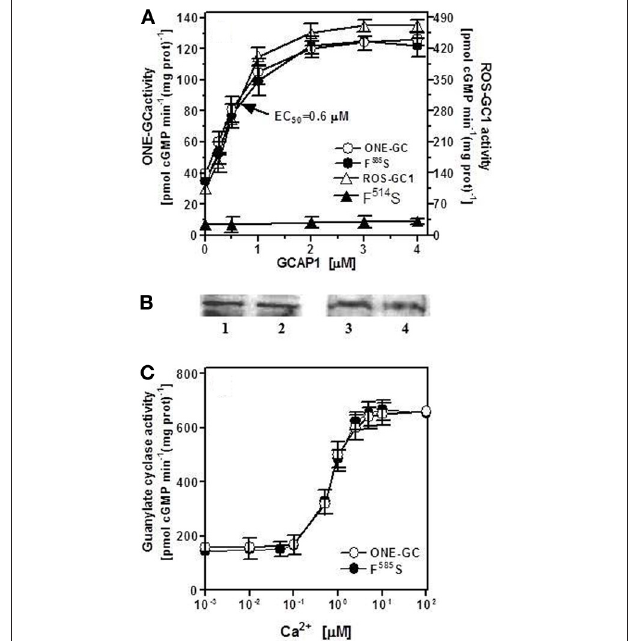
FIGURE 8 | F 585 S mutation does not affect Ca 2 + -GCAP1 signaling of ONE-GC activity. (A) Membranes of COS cells expressing ONE-GC or its F 585 S mutant were assayed for guanylate cyclase activity in the presence of increasing concentrations of GCAP1 and constant 10 μ M Ca 2 + ; Membranes of COS cells expressing ROS-GC1 or its F 514 S mutant were analyzed for GCAP1 effect in the absence of Ca 2 + (1mM EGTA was present in the assay mixture). (B) Membranes of COS cells expressing ONE-GC and its F 585 S mutant or ROS-GC1 and its F 514 S mutant were analyzed by Western blot using antibodies against ROS-GC1 and ONE-GC. Approx 20 μ g of membrane protein was applied on each lane of the gel. Lane 1, ONE-GC; Lane 2, ONE-GC F 585 S; Lane 3, ROS-GC1; Lane 4, ROS-GC1 F 514 S. (C) Membranes of COS cells expressing ONE-GC or its F 585 S mutant were assayed for guanylate cyclase activity in the presence of increasing concentrations of Ca 2 + and constant, 4 μ M GCAP1. The experiments were done in triplicate and repeated for reproducibility with different preparations of transfected COS cells. The results presented (mean ± SD) are from one representative